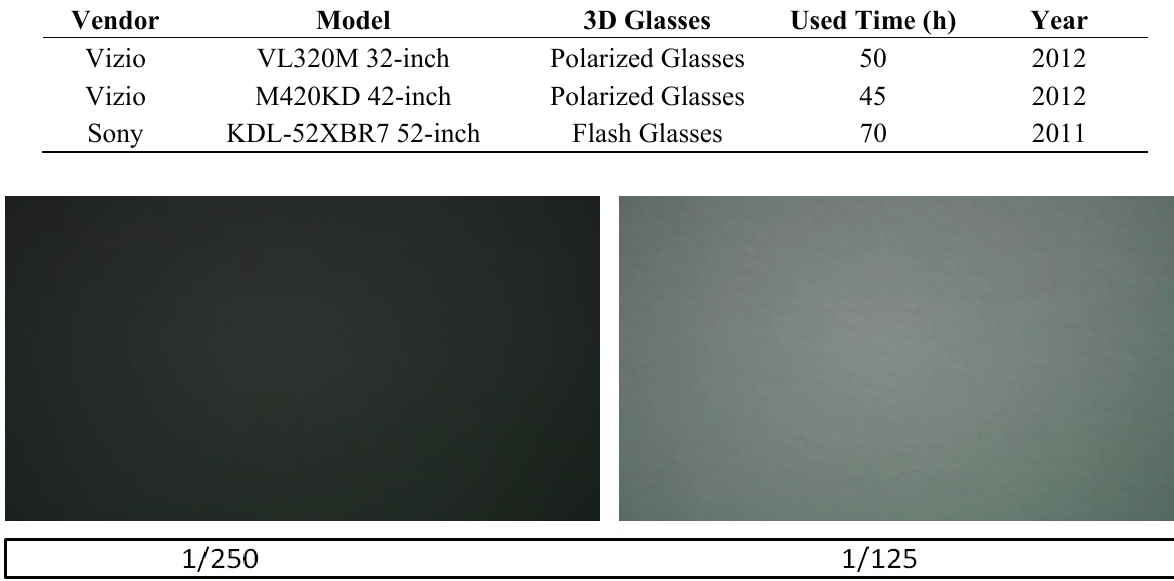
Figure 7. F5.6 aperture 2D/3D test images.